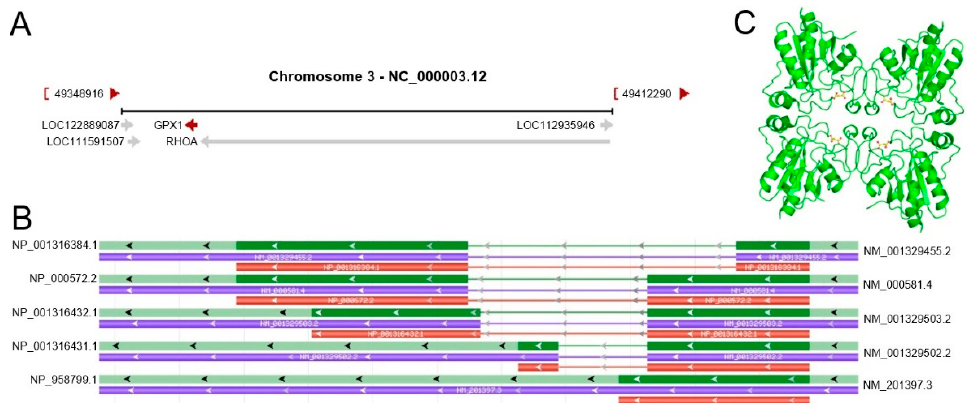
Figure 1. Transcription direction and gene structure of GPX1. ( A ) The red arrow indicates the negative transcription direction of GPX1. ( B ) The five transcript variants and their corresponding isoforms of GPX1 present in Genome Data Viewer (https://www.ncbi.nlm.nih.gov/genome/gdv/browser/gene/?id=2876, accessed on 1 May 2022). Isoform 1: NM_000581.4 → NP_000572.2; isoform 2: NM_201397.3 → NP_958799.1, isoform 3: NM_001329502.2 → NP_001316431.1; isoform 4: NM_001329503.2 → NP_001316432.1; isoform 5: NM_001329455.2 → NP_001316384.1. ( C ) The front view of the crystal structure of GPX1 protein tetrameric assembly from the Protein Data Bank in Europe database (https://www.ebi.ac.uk/pdbe/entry/pdb/2f8a/analysis, accessed on 1 May 2022).